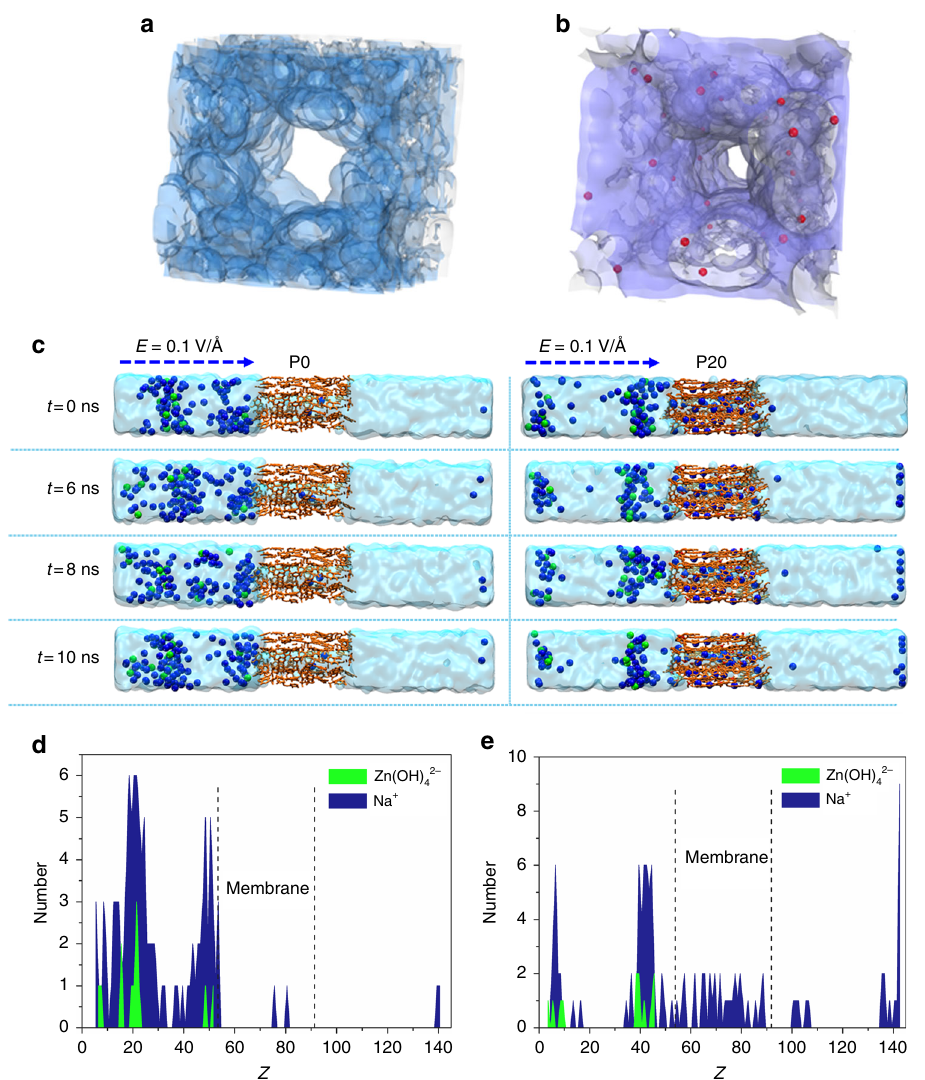
Fig. 5 Molecular dynamics simulation results using different membranes. a Accessible solvent surface model of P0. b Accessible solvent surface model of P20. The red spheres represent sulfonic acid groups. c Snapshots of the P0 and P20 membranes at different times, taken at 0, 6, 8, and 10 ns in an electric fi eld (E) of 0.1 V Å − 1 . The blue spheres represent Na + and the green spheres represent Zn(OH) 10 ns using P0 membrane. e Statistical distribution of Na + and Zn(OH) 4 2 − at 10 ns using P20 membrane. P20 is a negatively charged